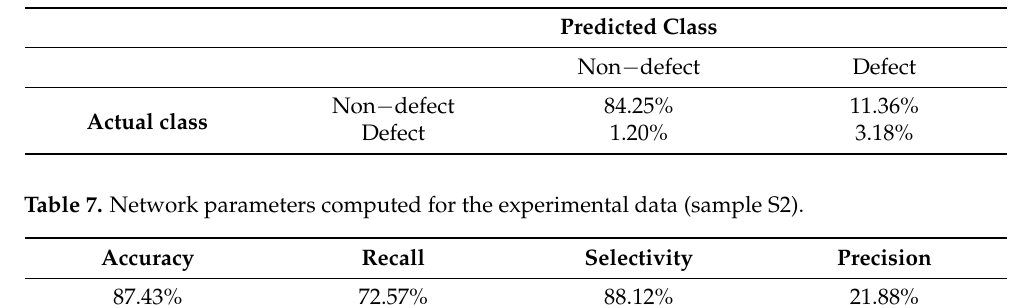
Table 6. Confusion matrix for the experimental data (sample S2).